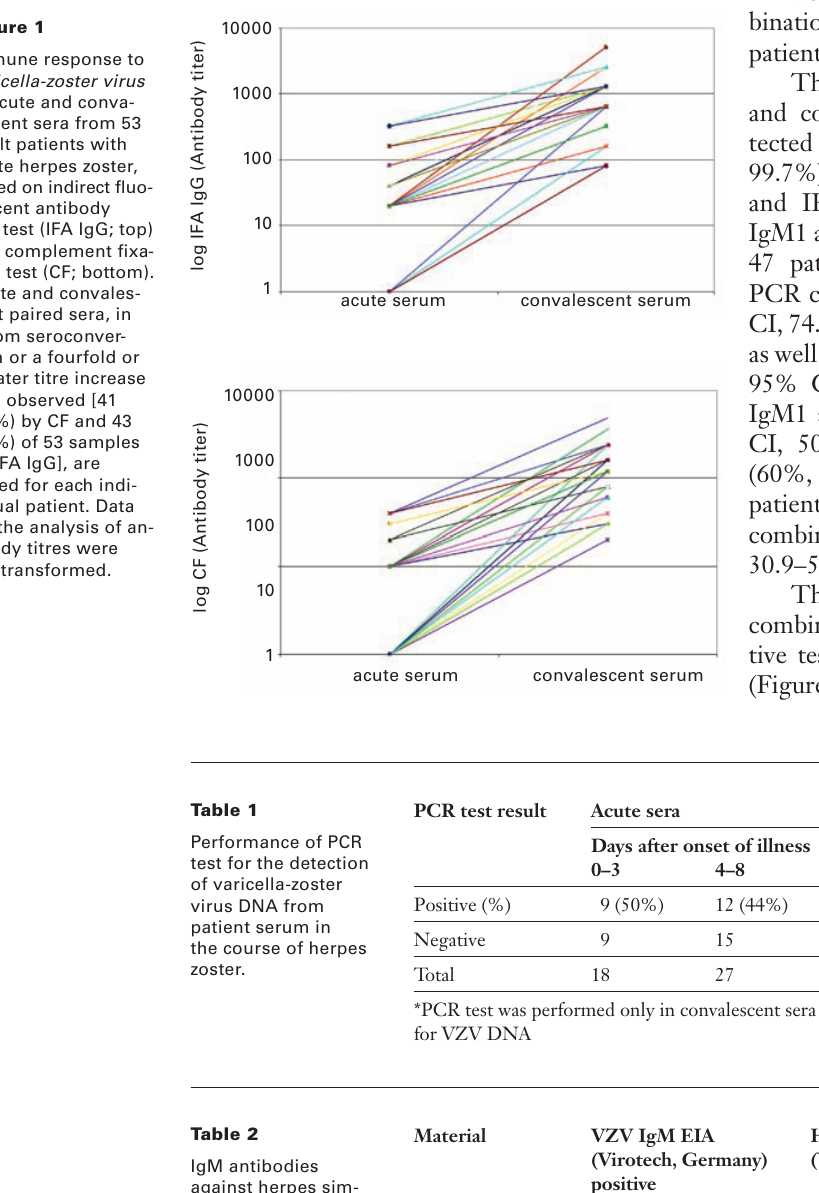
Table 2 IgM antibodies against herpes sim- plex virus (HSV) and Epstein-Barr virus (EBV) in acute and convalescent sera of 53 patients with her- pes zoster who tested positive for VZV IgM.